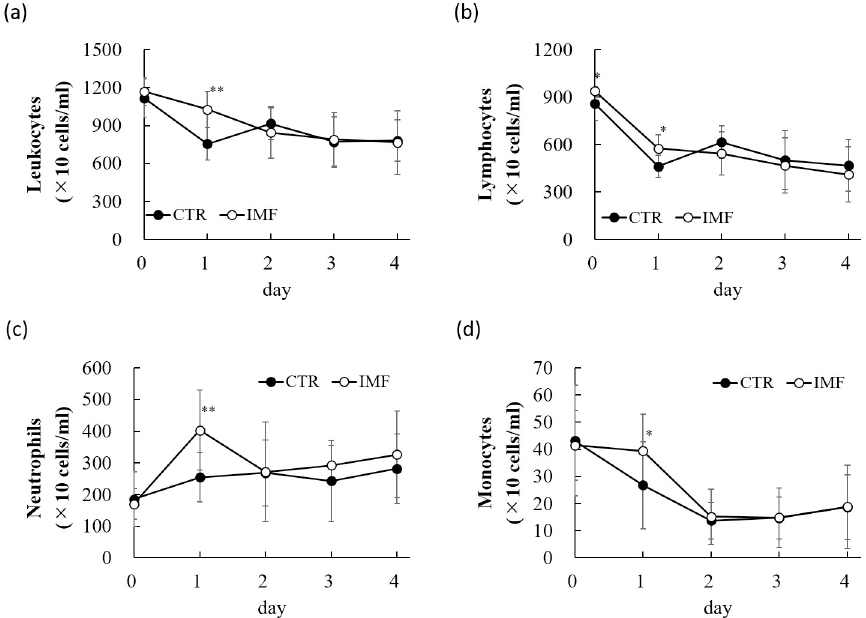
Fig 2. The counts of total leukocytes, lymphocytes, neutrophils, and monocytes after 5-FU injection. ( a ) total leukocyte counts, ( b ) lymphocyte count, (c) neutrophil count, and (d) monocyte count. Values are means ± standard deviations. � P < 0.05, �� P < 0.01, vs. CTR group.